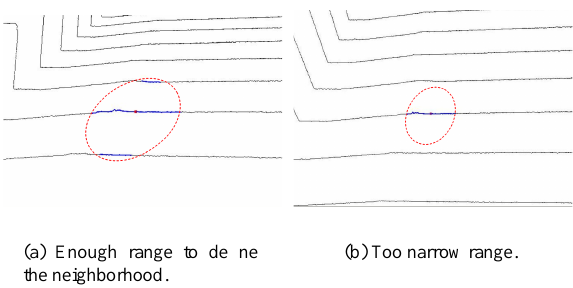
(a) Enough range to define the neighborhood. Figure 2: The necessity of wide neighborhood